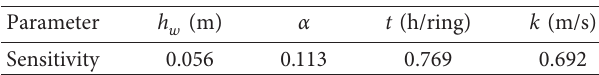
Table 5: Sensitivity of moisture content of discharged soil to each parameter.